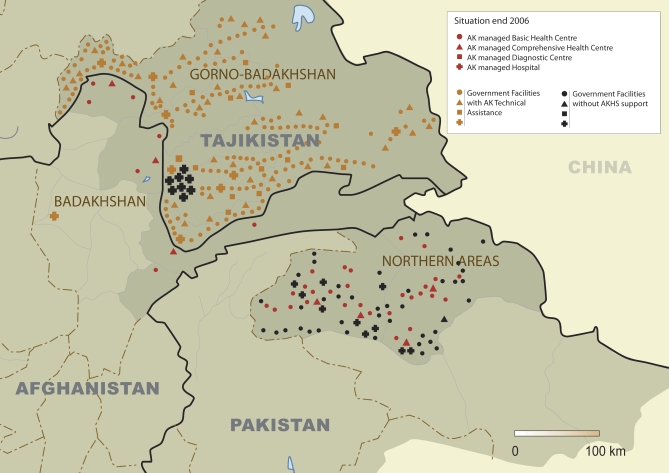
Health Facilities in the Border Districts of Afghan Badakhshan, the Northern Areas of Pakistan, and Gorno-Badakhshan in Tajikistan